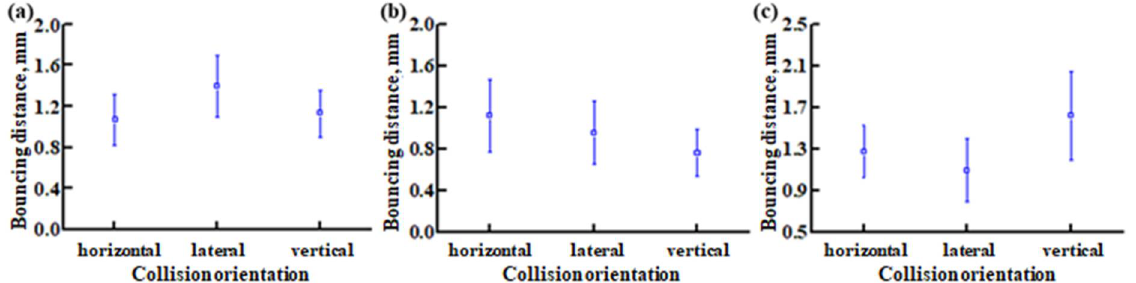
Figure 14. The relationship between bounce distance and impact orientation for ( a ) SN42, ( b ) JD17 and ( c ) ZD39.